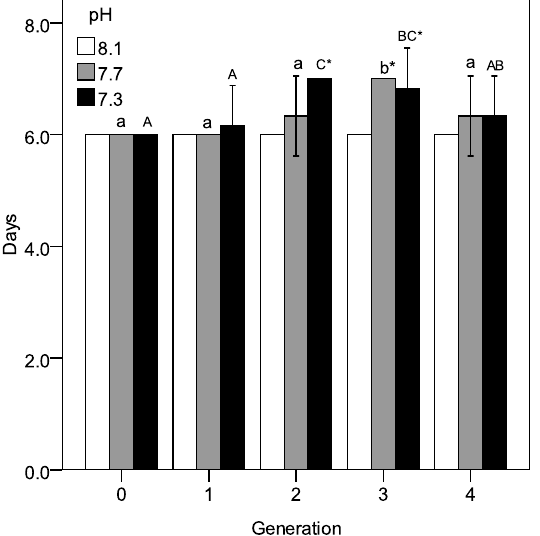
Figure 2. Effect of seawater acidification on copepodite developmental time (mean ± standard deviation, n = 3) of Tigriopus japonicus . All of the generations were exposed to the same pH levels. Statistical differences among generations ( p < 0.05) are represented by different letters. Asterisks (*) indicate significant differences ( p < 0.05) in the developmental rate between pH 8.1 and pH 7.7, as well as between pH 8.1 and pH 7.3 for each generation.